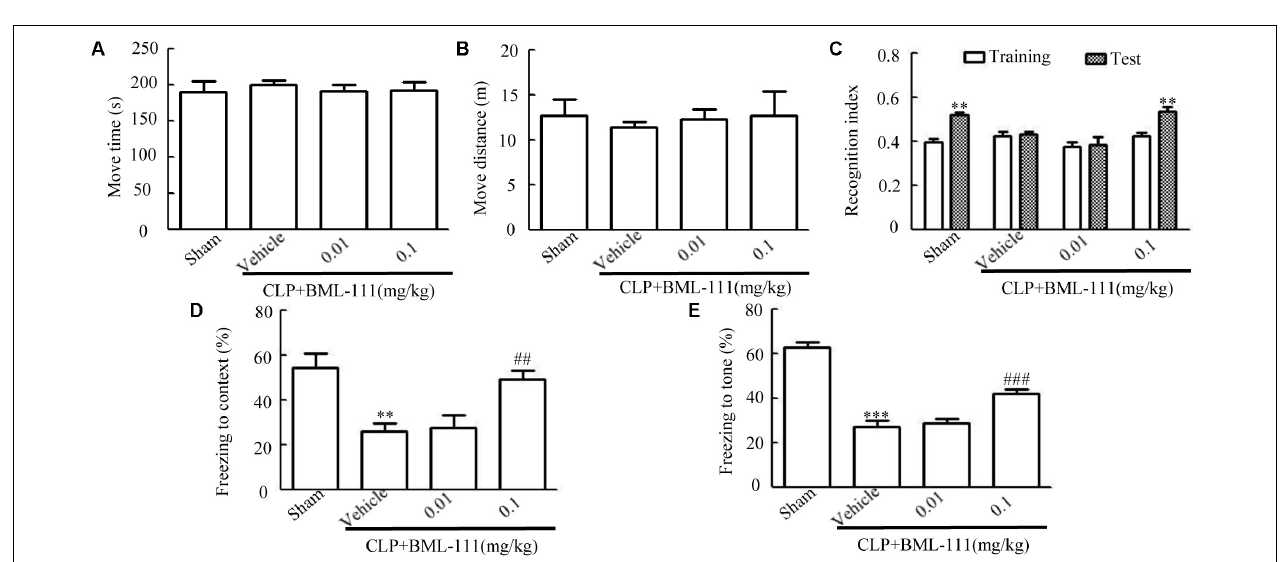
FIGURE 1 | Molecular formula and structure of BML-111 (A) and a schematic representation of the experiments (B,C) .